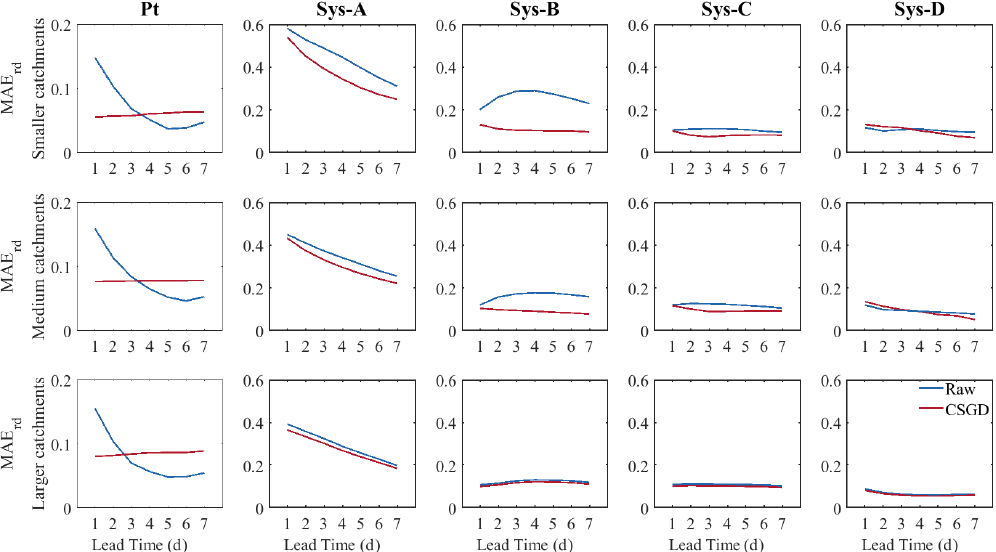
Figure 8. MAE rd for raw (blue) and precipitation post-processed (red) forecasts for precipitation (Pt) and streamflow forecasts as a function of forecast lead time. The first column represents the MAE rd for the raw and post-processed precipitation forecasts. The remaining columns represent the four streamflow forecasting systems (A, B, C, and D). On top: the smaller catchment group. In the middle: the medium catchment group. On the bottom: the larger catchment